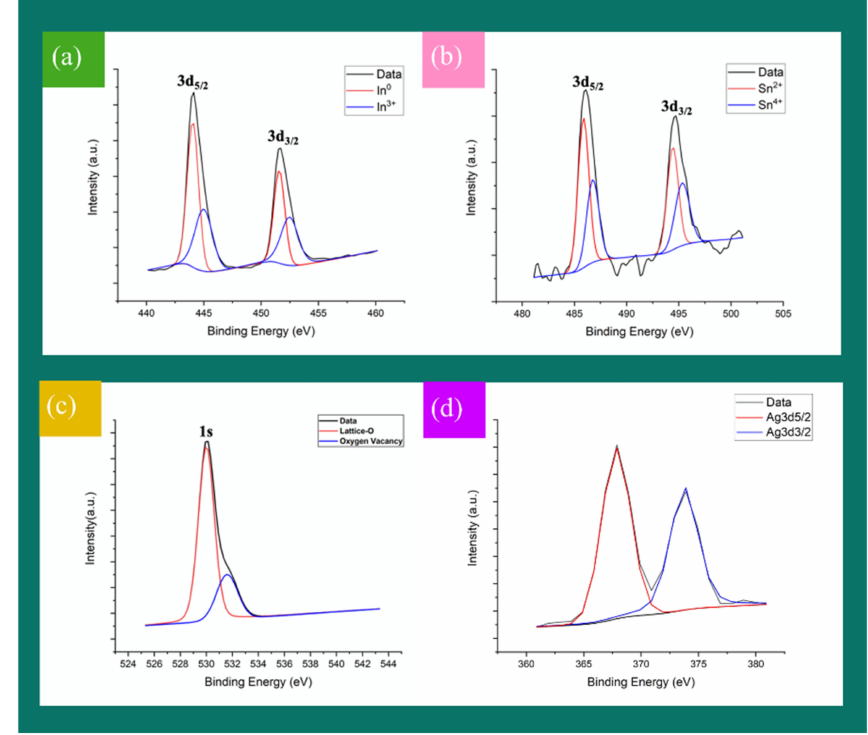
Figure 5. XPS interpretation of spectra for ( a ) In ( b ) Sn ( c ) O ( d )